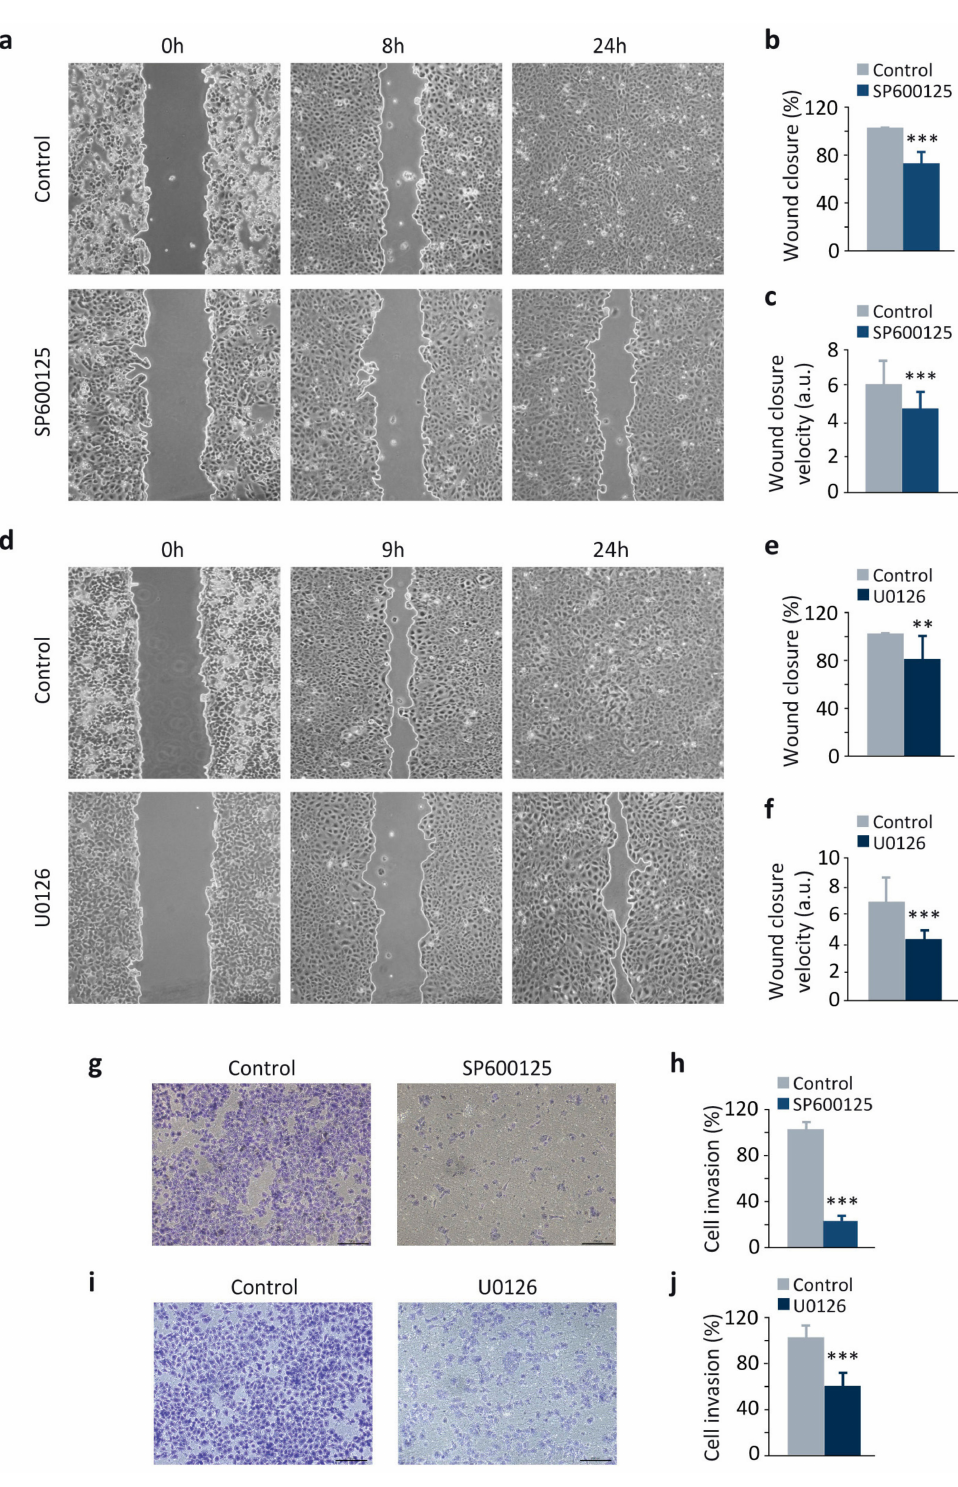
Figure 3. The inhibition of JNK and ERK decreases migration and invasion in DU145 cells. ( a – f ) Wound healing assay and measurement of wound closure area and velocity in cells incu- bated for 48 h with 10 µ M SP600125 ( a – c ) or 20 µ M U0126 ( d – f ). ( g – j ) Invasion capacity using transwell assays in cells incubated as above. For all the results, data are shown as the mean ± SEM of at least three independent experiments. Pictures are from one representative experiment of three with similar results. Student’s t test: ** 0.001 < p < 0.01; *** p <